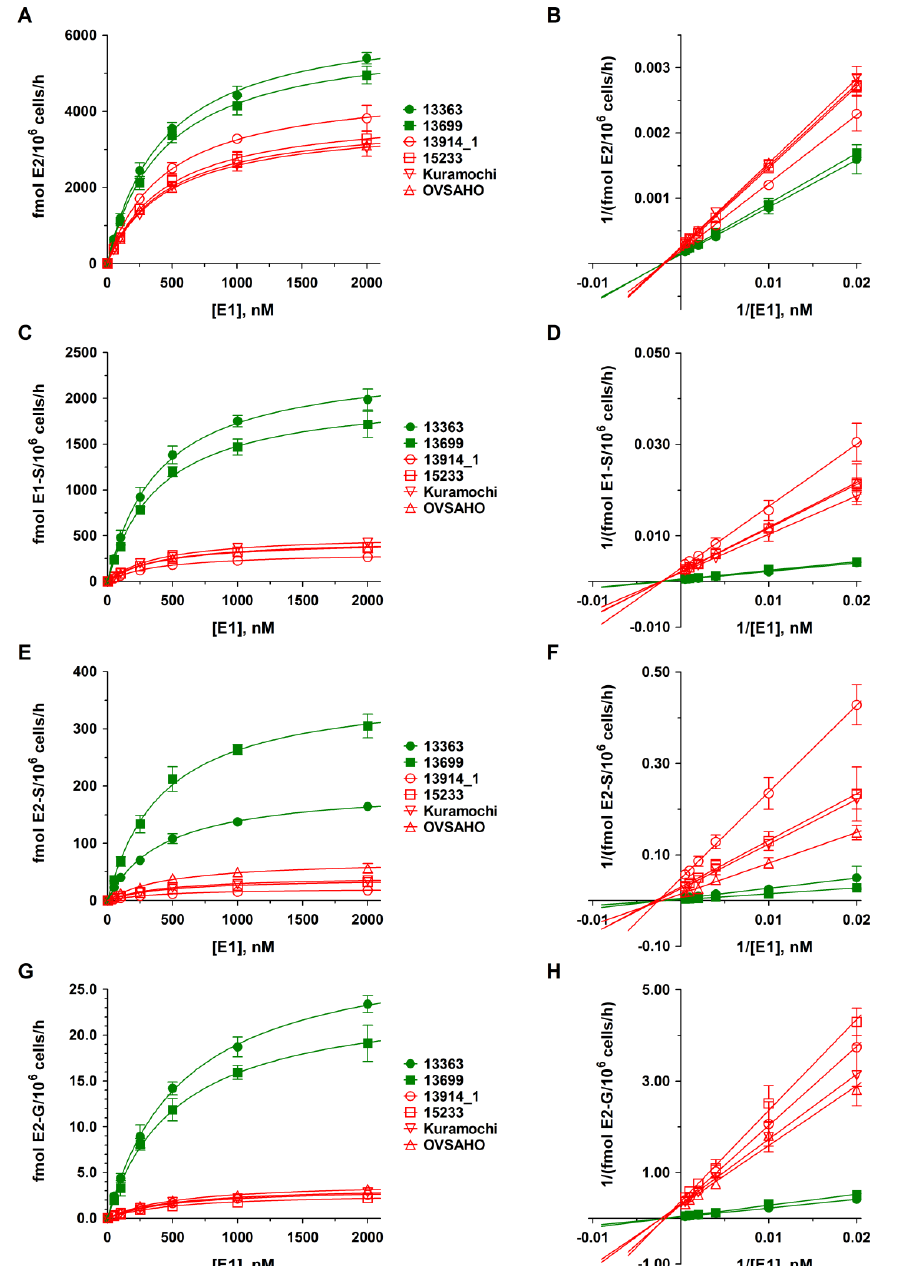
Figure 3. Kinetic profiles of E1 metabolite formation in platinum-sensitive and -resistant HGSOC cells. The kinetics of ( A – B ) E2 formation, ( C – D ) E1 sulfation, ( E – F ) E2 sulfation, and ( G – H ) E2 glucuronidation were calculated following the incubation of all HGSOC cell lines with 0 to 2000 nM E1 as a hormone precursor for 48 h. Data are displayed as Michaelis – Menten and Lineweaver – Burk plots and represent the means ± SD of three independent experiments. Green curves indicate sensitivity and red curves indicate resistance against carboplatin to the investigated HGSOC cell lines. Differences were statistically significant between these two groups ( p < 0.05).